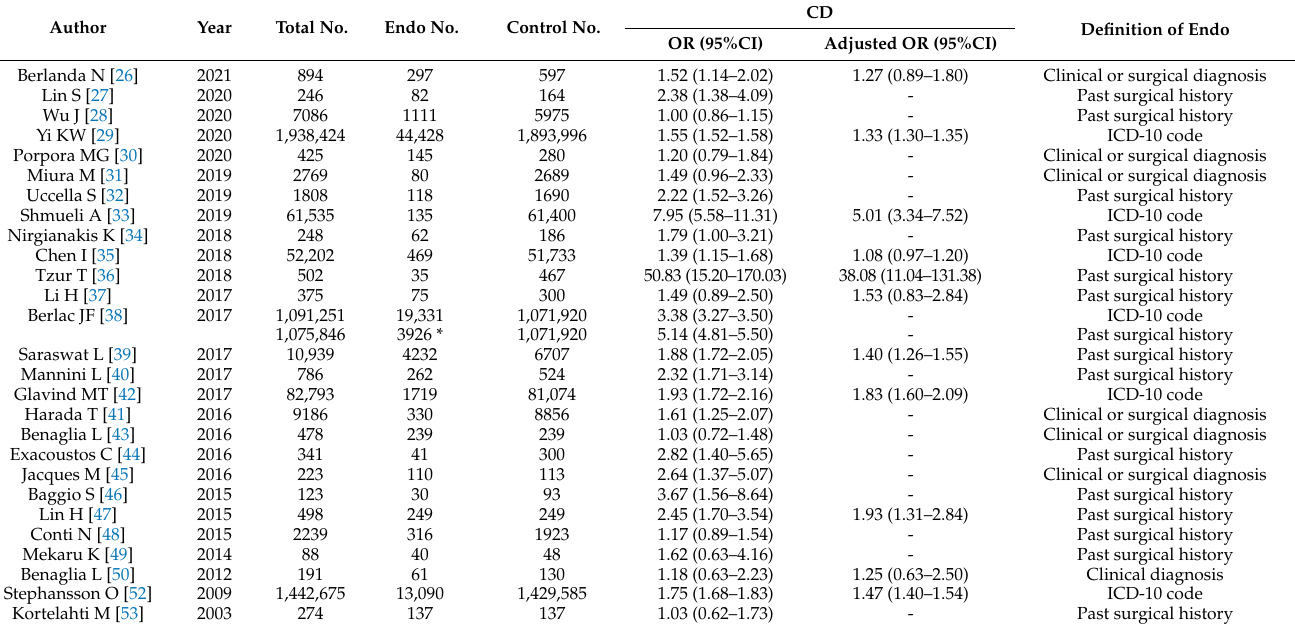
Table 2. Comparator analysis of the rates of CD between women with and without endometriosis.